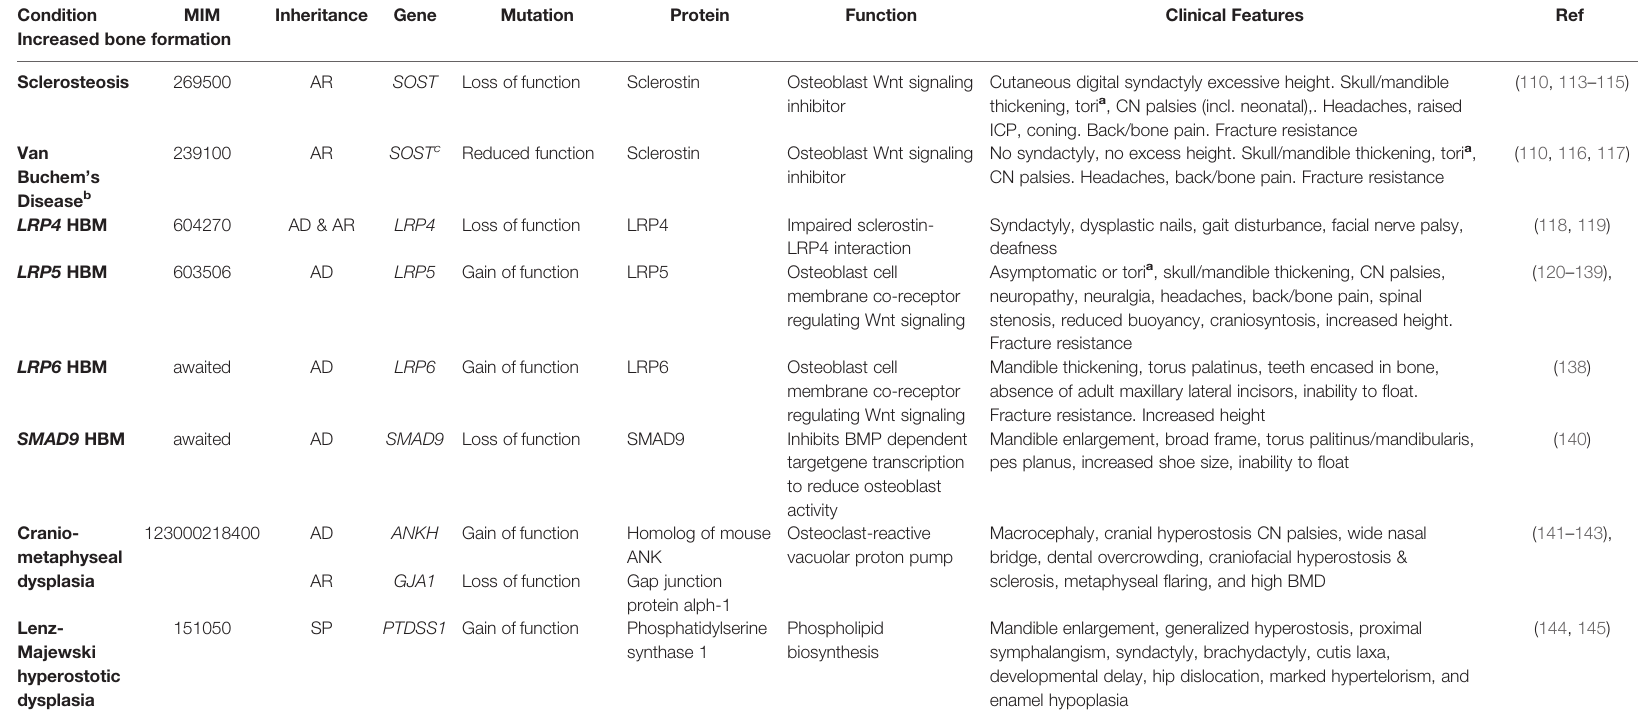
TABLE 2 | Inherited HBM conditions due to enhanced bone formation: gene defects, function, and clinical characteristics.